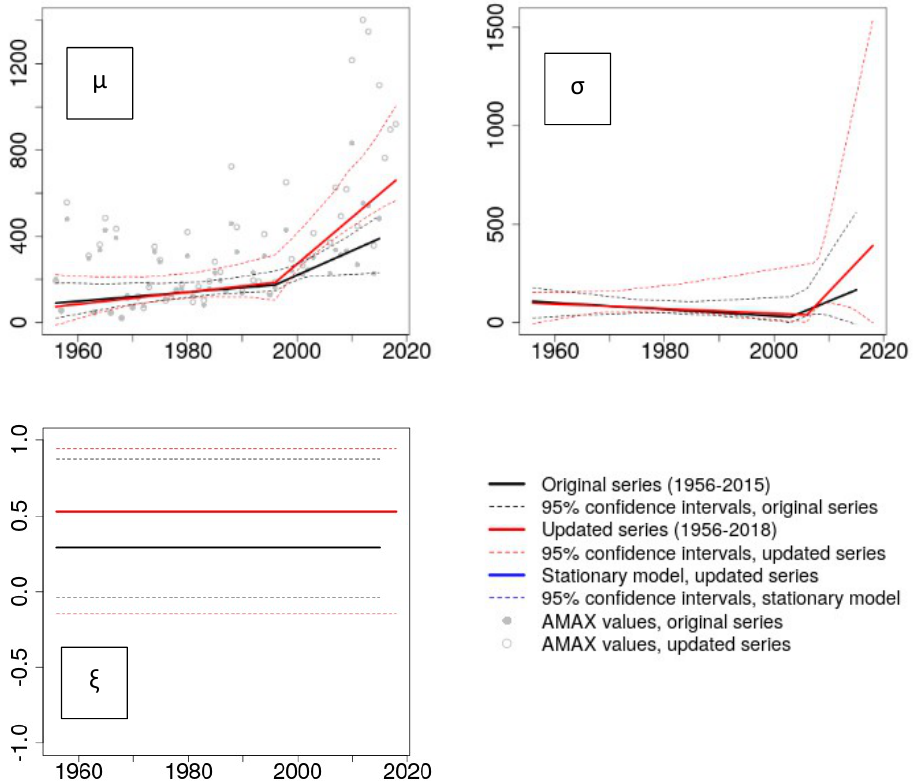
Figure 9. Time variation of the GEV parameters for both the old and the updated discharge time series: top left µ (central tendency) parameter, top right σ (dispersion) parameter and bottom left ξ (shape) parameter.